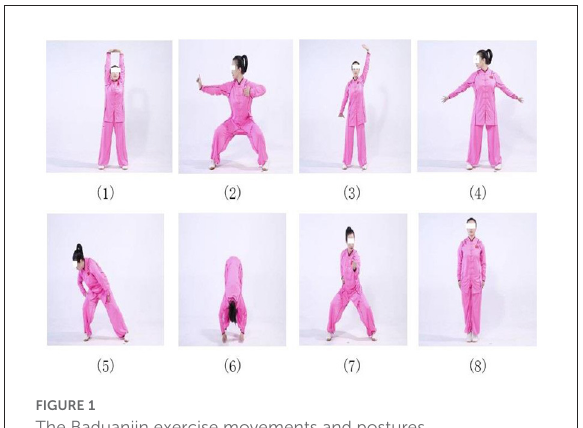
FIGURE1 The Baduanjin exercise movements and